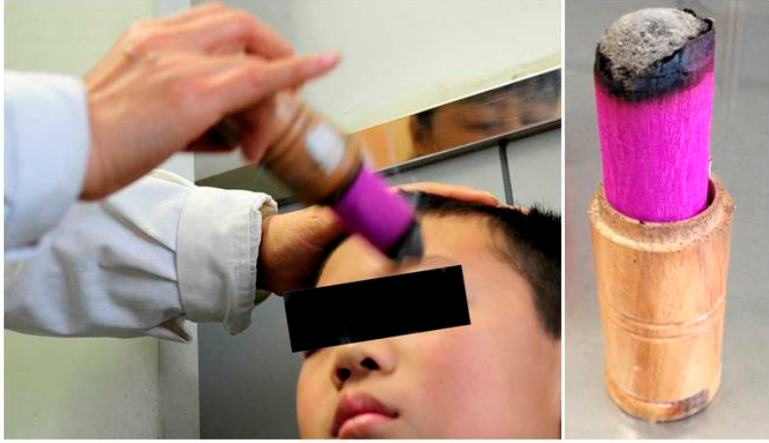
Figure 3. A part of the moxibustion treatment in 22 young patients with myopia (group B).